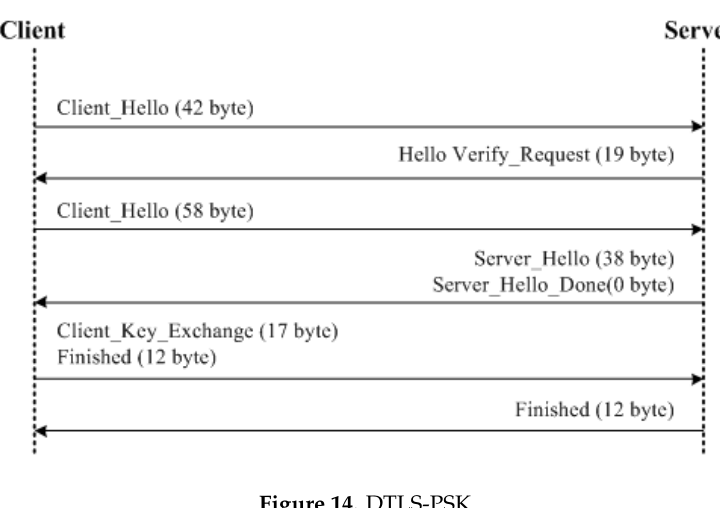
Figure 14. DTLS-PSK.